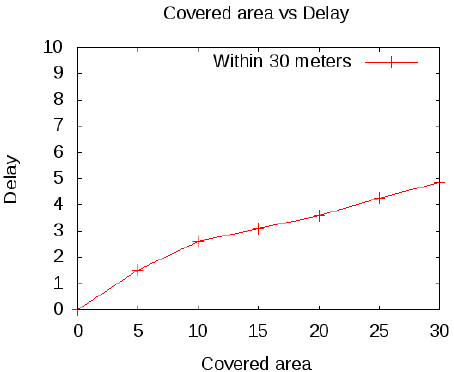
Figure 6. Negative ACK due to absence of spoofing attack. As the negative ACK decreases, there is a decrease in the packet drop and core reconfiguration, which ultimately decreases the delay as shown in Figure 7. Hence, the node in the group behaves normally in terms of negative ACK and delay.